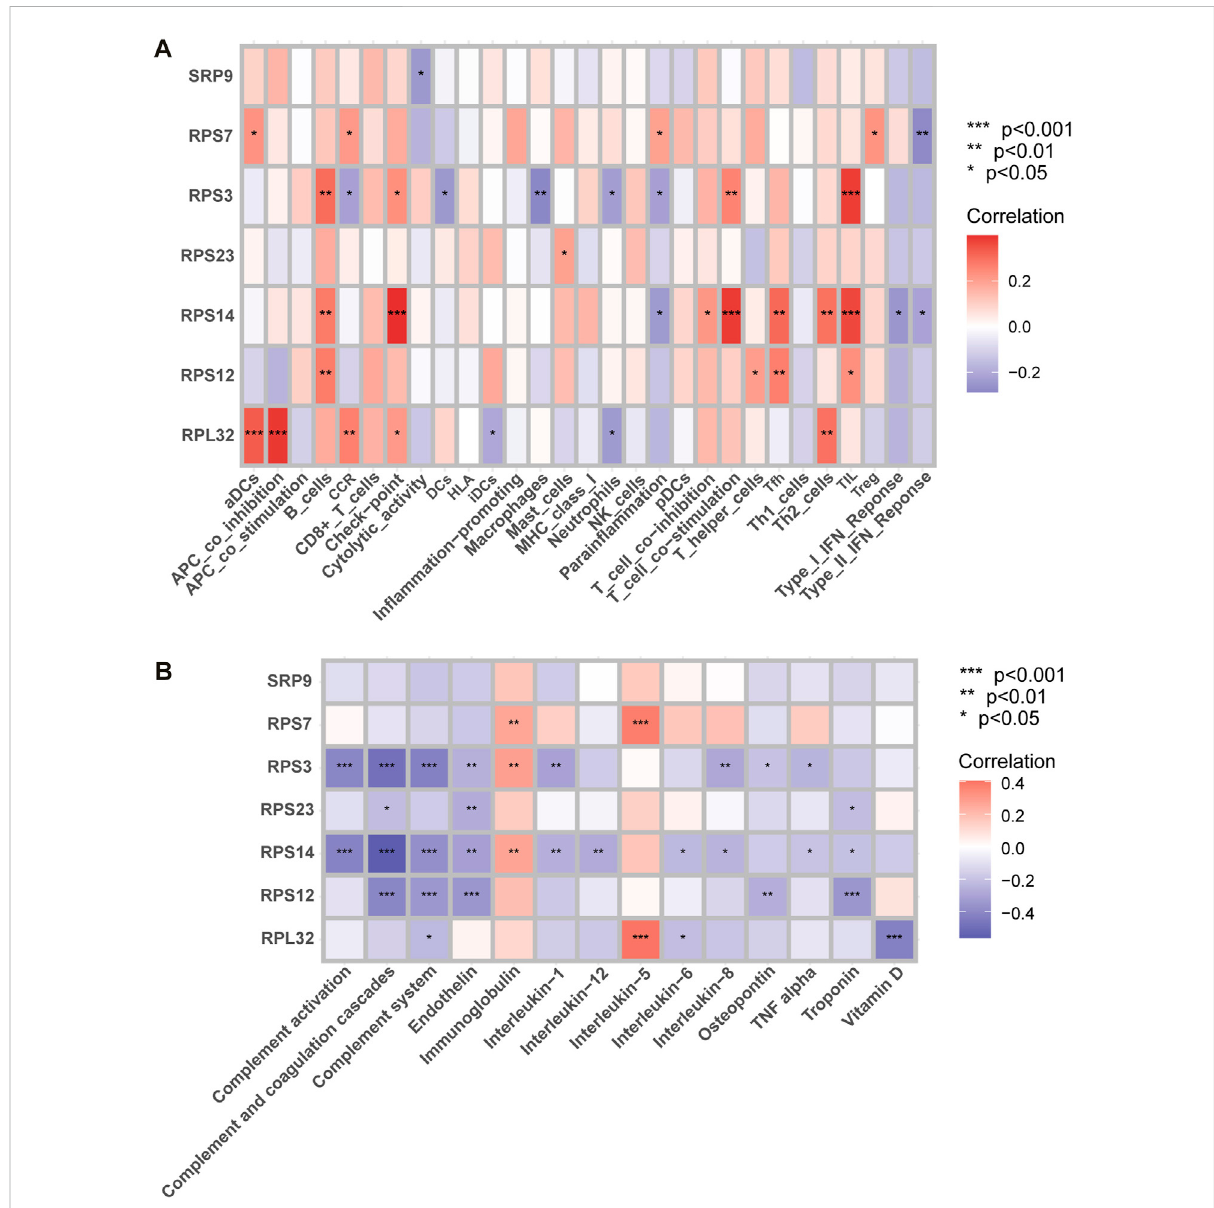
FIGURE 11 Correlation analysis. (A) Correlation analysis between SRP-DGs and immune characteristics. (B) Correlation analysis between SRP-DGs and SSc-PH-related pathways. Red represents positive correlations, and purple represents negative correlations. The deeper the color, the greater the correlation. *, p < 0.05; **, p < 0.01; ***, p <